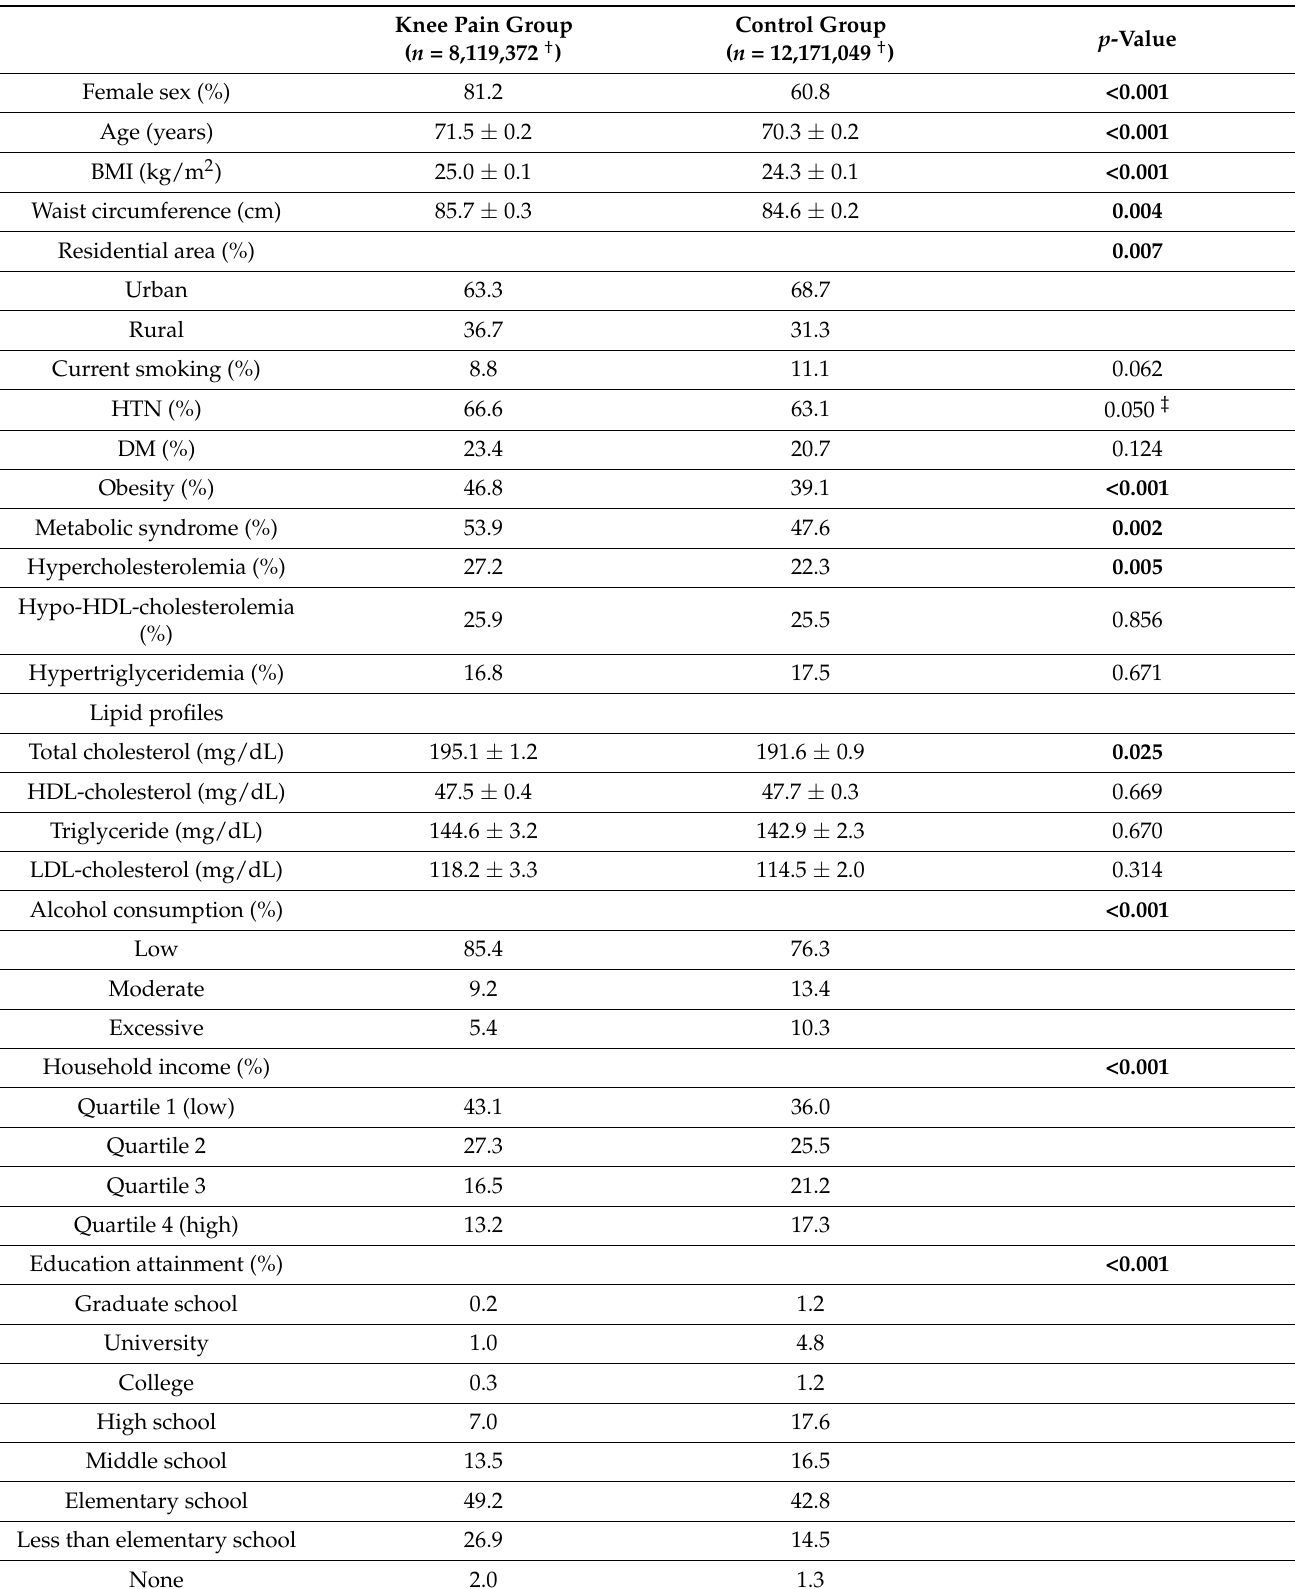
Table 1. Demographic characteristics of two subgroups divided by the presence of knee pain among subjects with radiographic